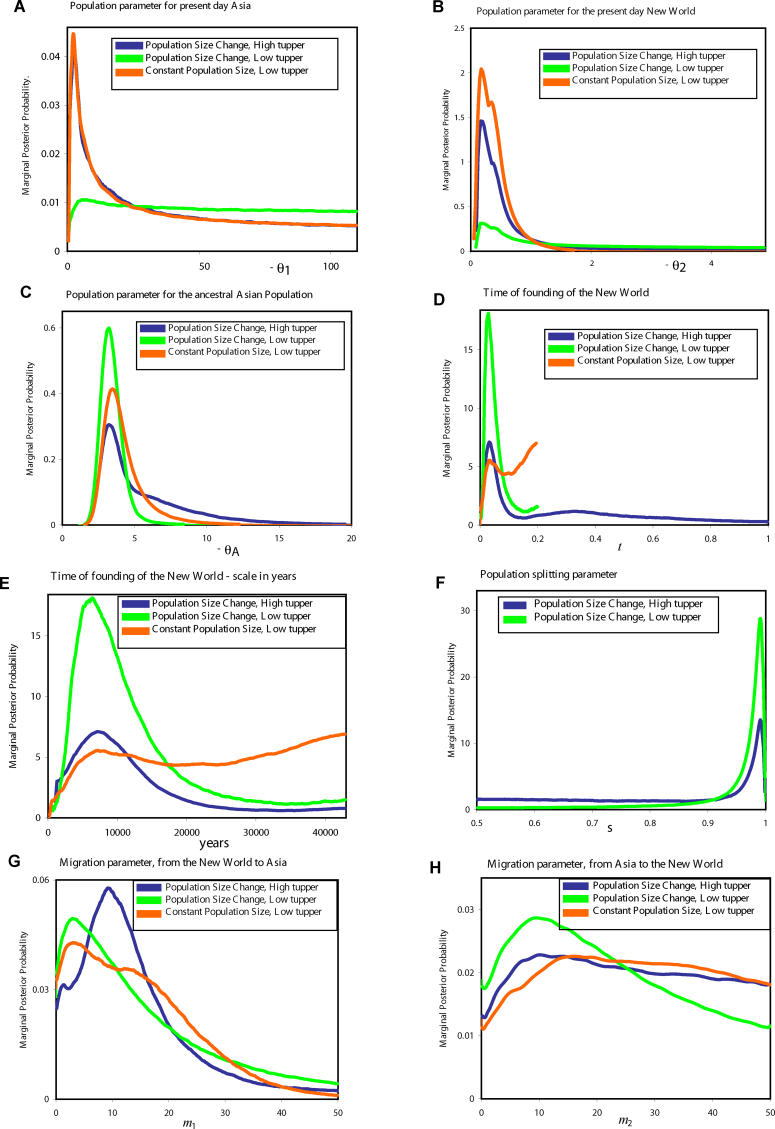
Marginal Posterior Probability DensitiesProbability densities for each of the parameters described in Figure 1 are shown, as follows: (A) θ1; (B) θ2; (C) θA; (D) t (i.e., t/u); (E) t shown on a scale of years over the range corresponding to a maximum t value of 0.2; (F) s; (G) m
1; and (H) m
2. The analysis in which a high upper limit on the prior distribution for t was used is identified as “high tupper,” while those analyses with a smaller upper limit on the prior distribution of t are identified as “low tupper.” Each curve is based upon the results of multiple simulations over millions of Markov chain updates (see Materials and Methods), and is plotted over the specified prior range of that parameter.